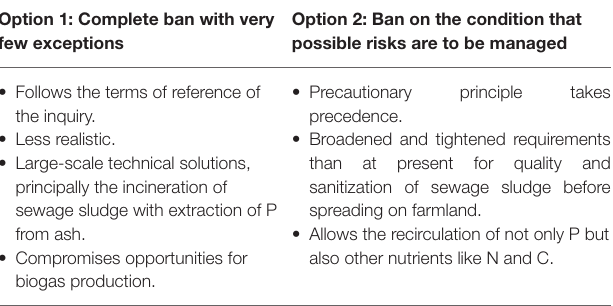
TABLE 1 | Recommended options for future sewage sludge management in Sweden (Extract from the on-going inquiry, SOU, 2020:3). Option 1: Complete ban with very few